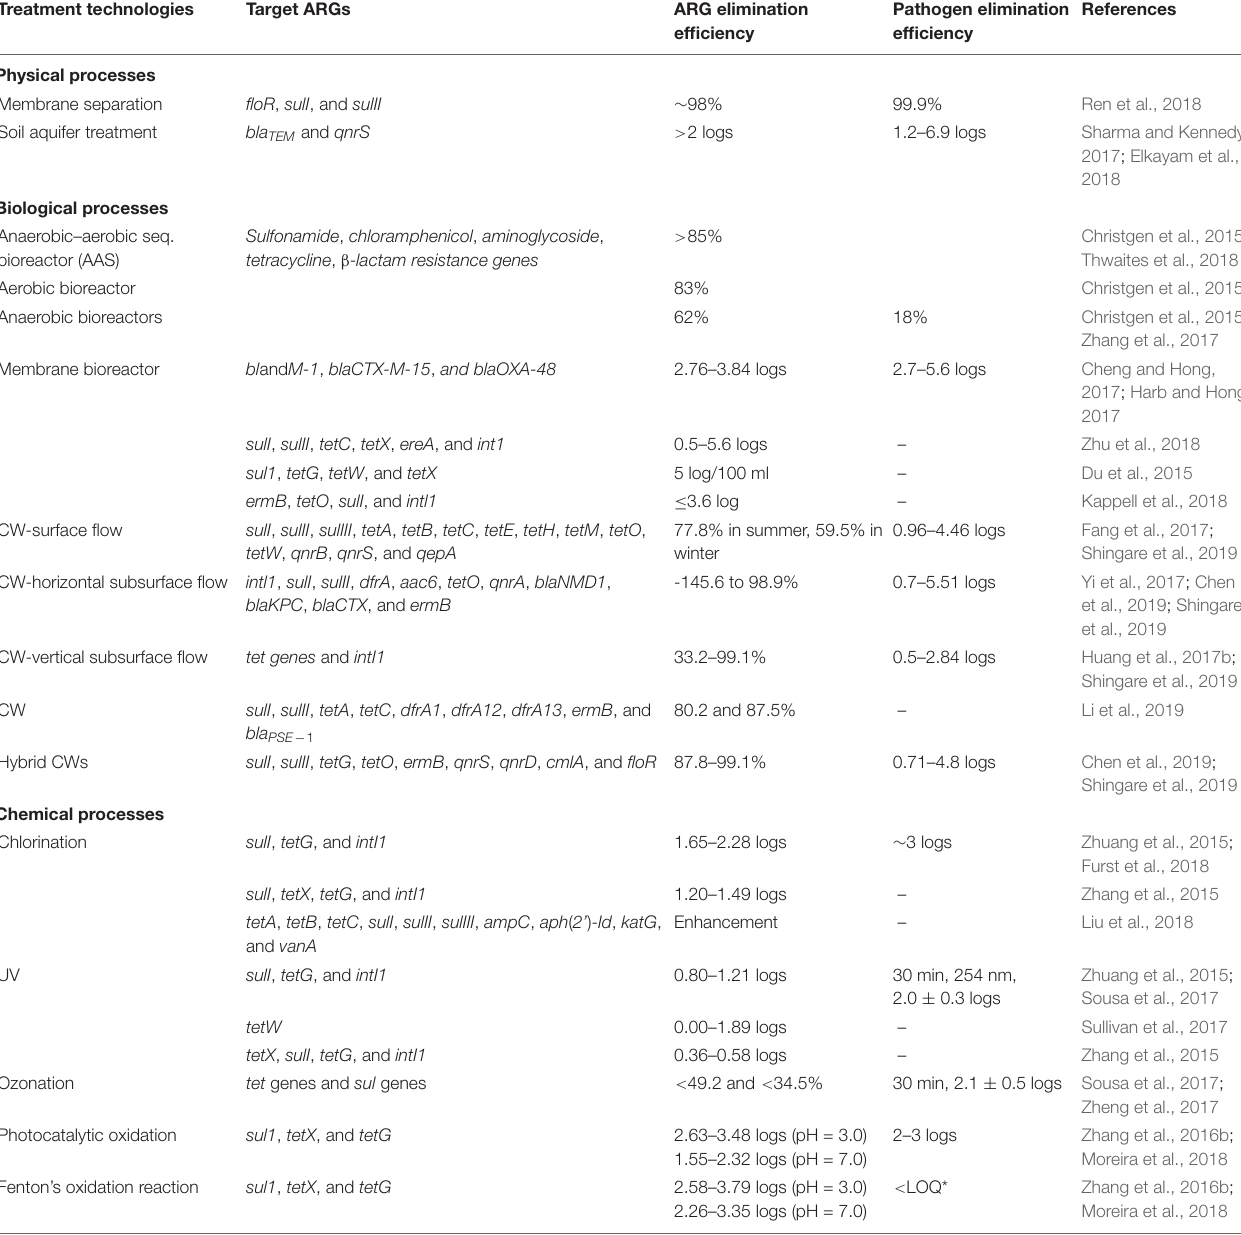
TABLE 2 | Antibiotic resistance gene (ARG) and pathogen elimination efficiencies of different treatment